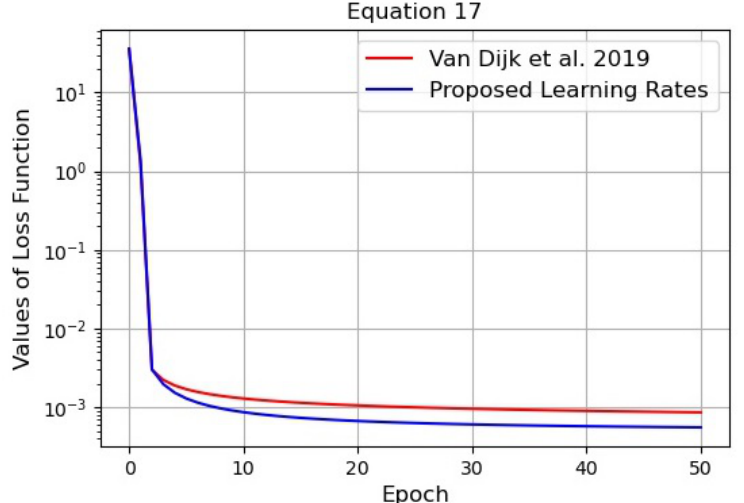
Figure 3. Values of loss function and convergence rate for w-convex binary problem (Equation (17)) [1].